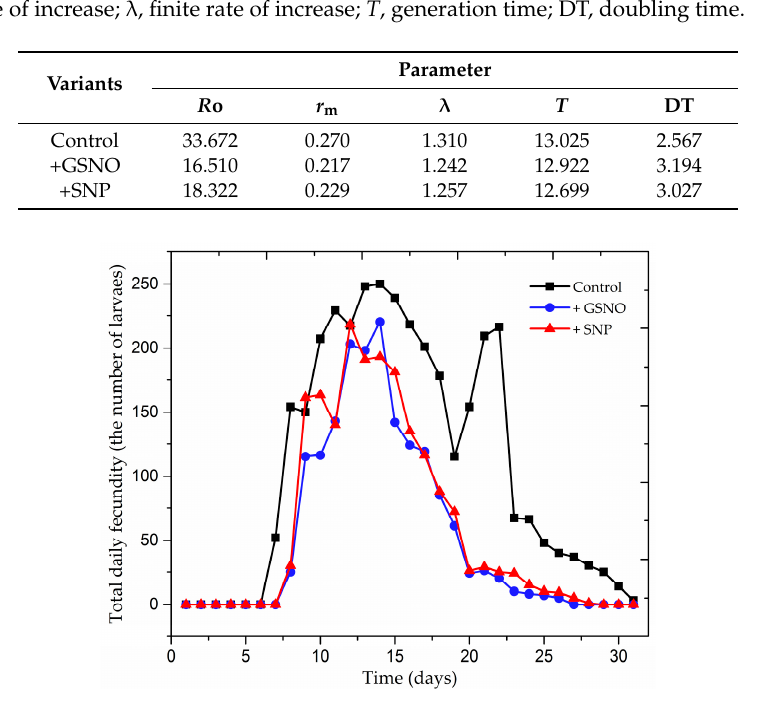
Figure 1. Effect of nitric oxide donors on fecundity of 20 apterous females Acyrthosiphon pisum cultured on the Pisum sativum L. cv. Cysterski seedlings. Values are means ± SE from 20 replicates per treatment. Hypotheses on equality of means were verified by the two-sample t -test (Table S1). To account for multiple testing, we used the Bonferroni correction.